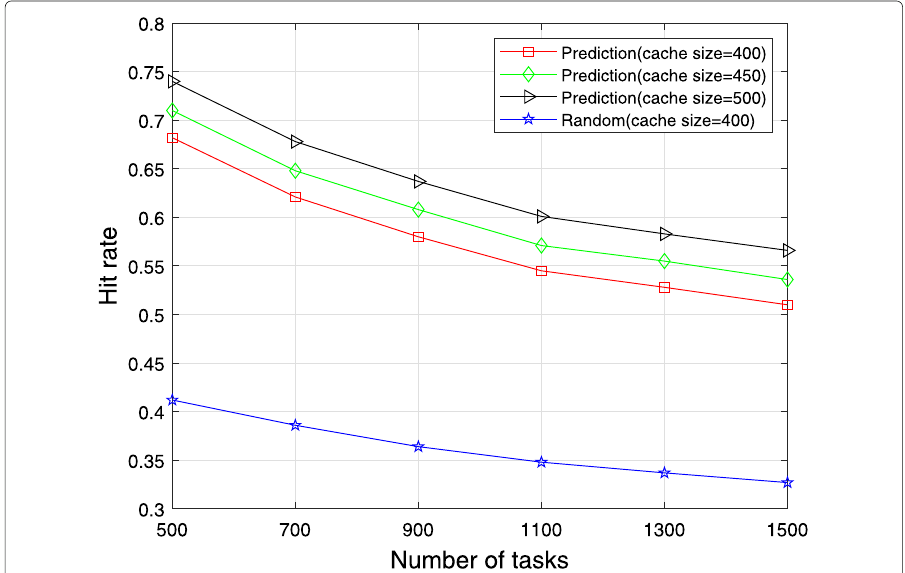
In addition, when the cache size of the BS are 450 and 500, the latency reductions of both schemes are higher than that of the scheme with cache size 400. So, when the cache space of the BS becomes bigger, the latency reduction for the whole system is higher than those of the other prediction schemes with less cache space. Therefore, the more cache space the BS has, the more latency is reduced. The results prove that latency reduction is affected by the number of users and cache size.